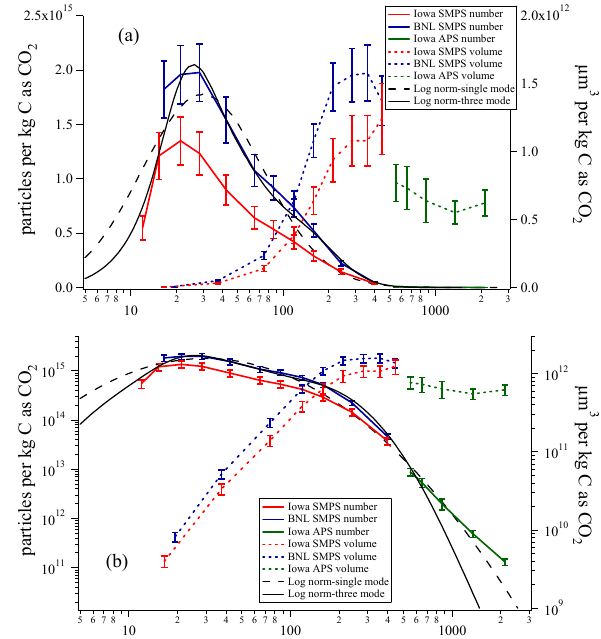
Figure 7. Grand average number and volume emission factor distributions shown on both a log-linear (a) and a log-log (b) scale. These distributions represent the emission factors as determined using the data from 4:00 AM to 10:00 AM CST only, which was the time period with the strongest correlation between number and carbon dioxide. Error bars represent the 95% confidence interval based on variability in sampled values (see text for discussion of additional sources of uncertainty). The single mode and the three mode lognormal fits are also shown (see Table 4, rows 1 and 4 respectively for parameters).